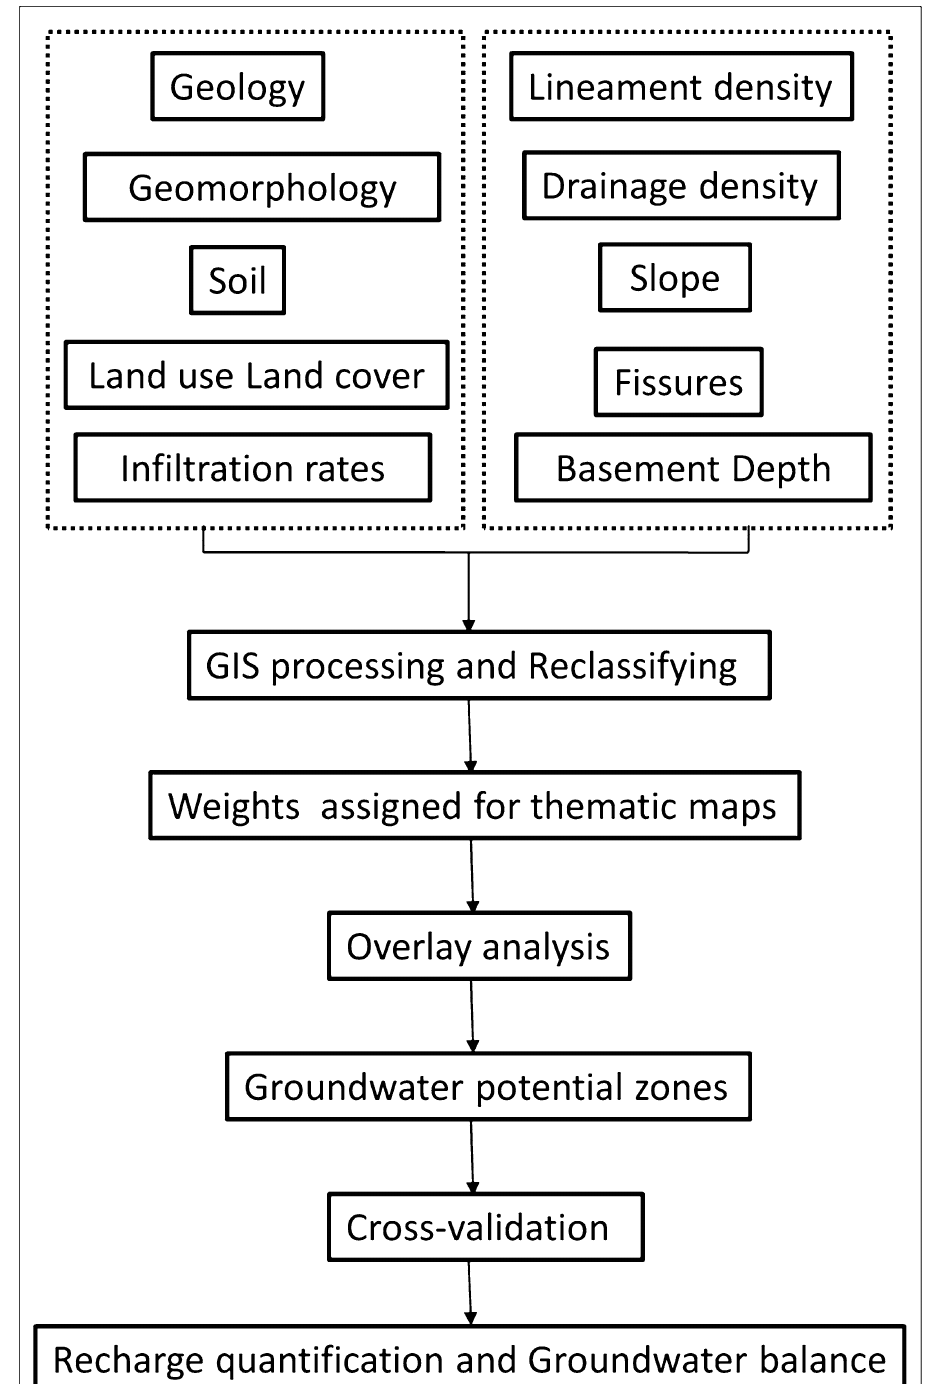
Figure 4. Flow chart showing WOI methodology adopted in the study area for the evaluation of potential groundwater recharge